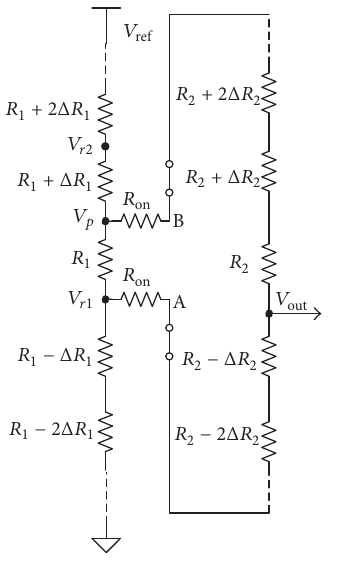
Figure 16: The model of resistors